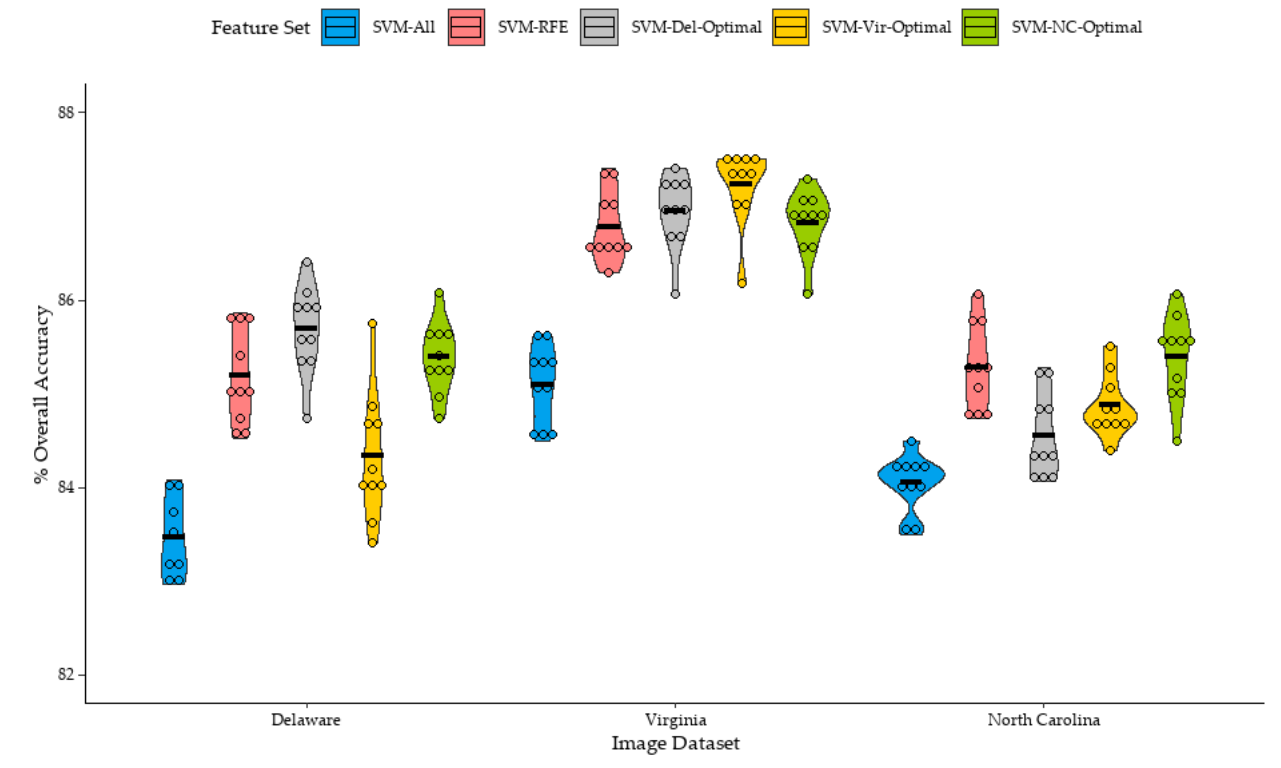
Figure 8. Distribution of overall accuracies of classifications trained from large sample sets. The black horizontal bar indicates the mean overall accuracy for each classification method while the circles approximate individual overall accuracy values of classifications.